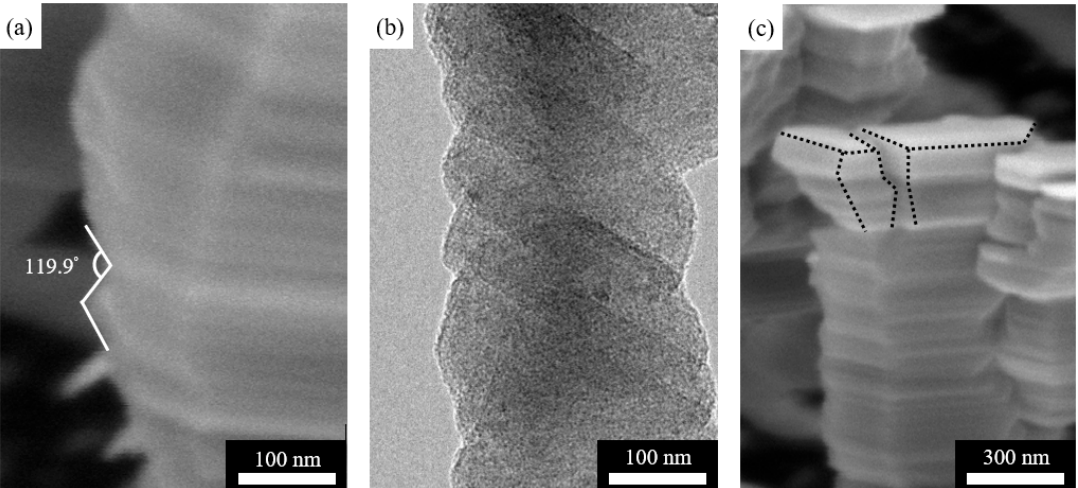
Figure 3. ( a ) SEM image of a nanorod with faceted side surfaces, ( b ) TEM image of a nanorod with faceted side surfaces, and ( c ) SEM image of a bifurcated nanorod with no branches.